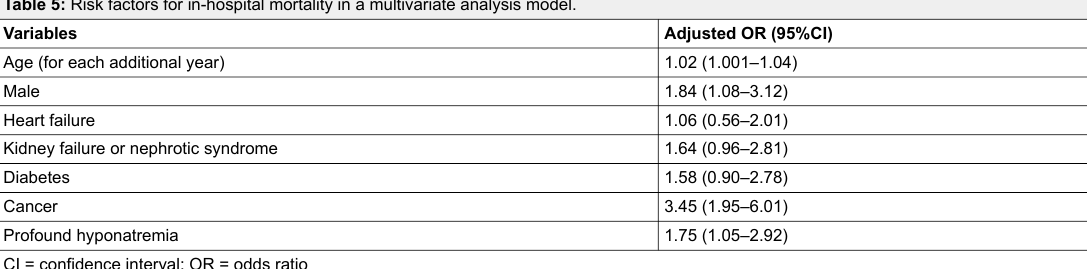
Table 5: Risk factors for in-hospital mortality in a multivariate analysis model.